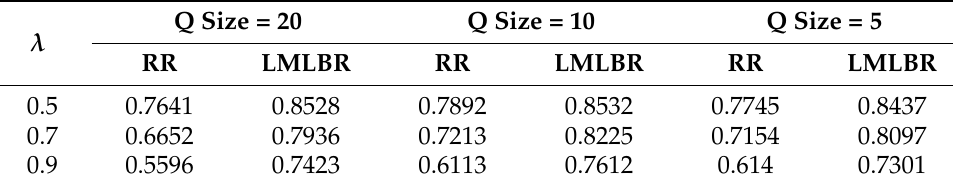
Table 5. Rate of tasks completed within the delay constraints versus queue